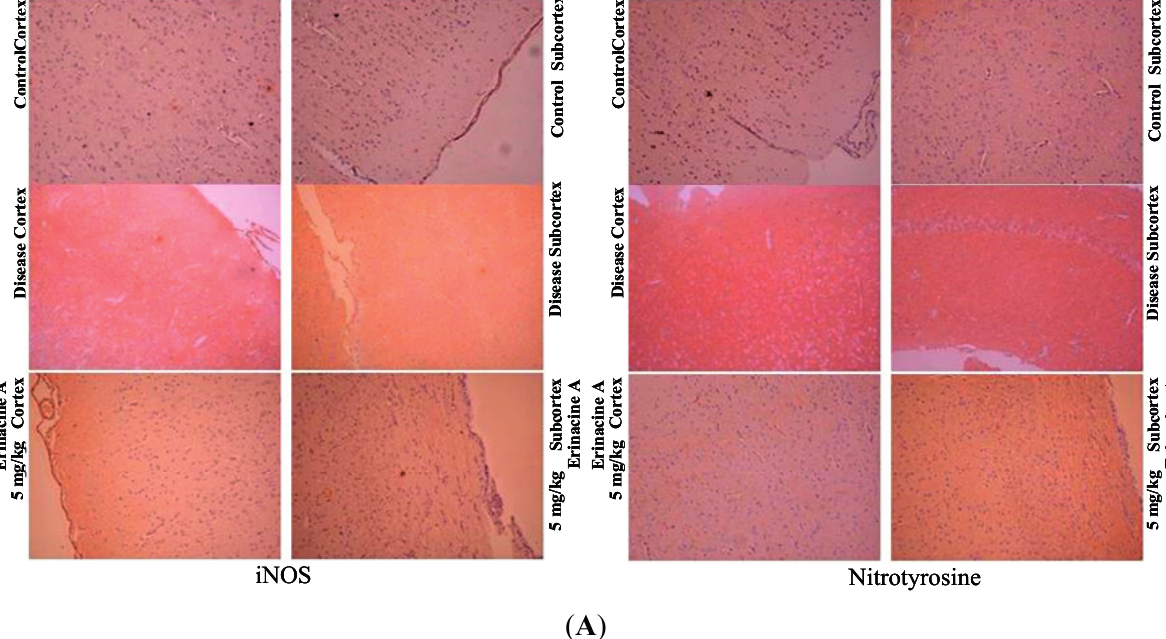
Figure 5. Effect of erinacine A on brain histological iNOS and nitrotyrosine protein expression in a transient stroke animal model. Rats were treated as described. Histological examination of the brain revealed the cortex and subcortex zones as indicated by immunohistochemical staining. ( A ) Rats were sacrificed and the brains were separated. Results show representative brain sections stained for the control group (CL); rats with transient SAM; Erinacine A treatment (10 mg/kg) staining of brain tissue; ( B ) Evaluations of nuclear protein expression and iNOS and nitrotyrosine expression were quantitative in the cortex zone and subcortex zone. The positive stained area was evaluated from three randomly selected observation fields of each brain cortex and subcortex